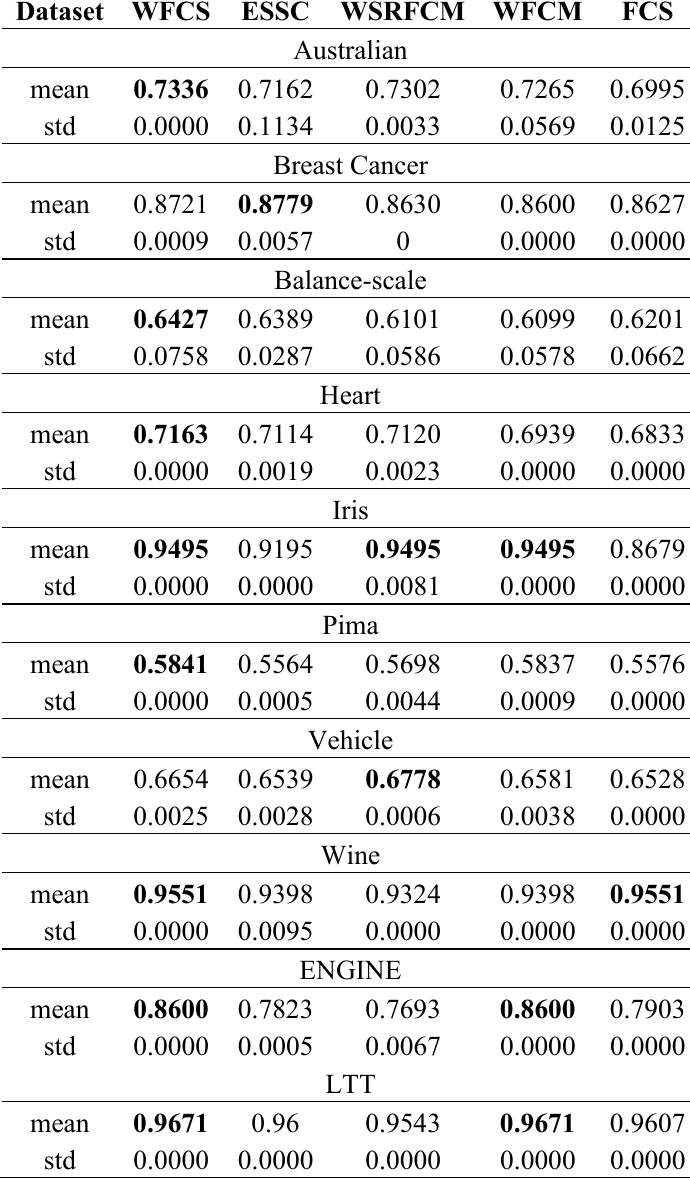
Figure 6. The average performances of the five algorithms. Table 4. The best clustering results obtained for the 10 datasets with rand index